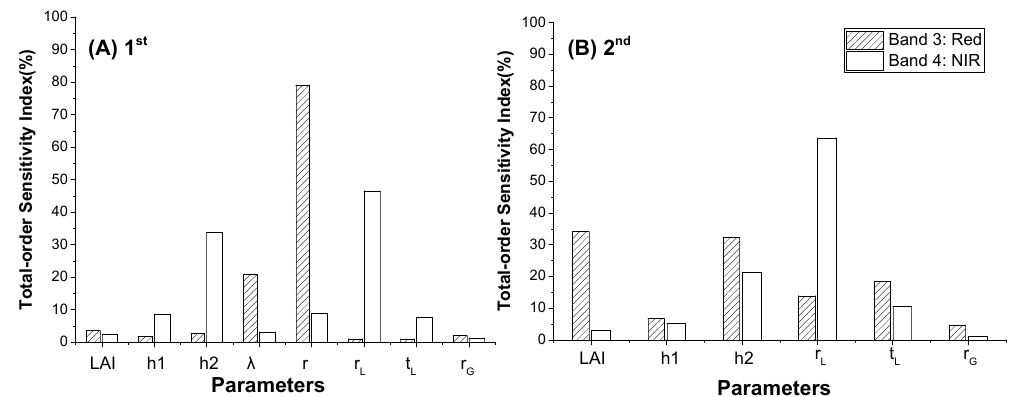
Figure 4. Results for the first ( A ) and second ( B ) global sensitivity analyses of the GORT model in the third (red) and fourth (NIR) Landsat bands for the following parameters: LAI (leaf area index), h 1 (lower boundary of canopy center height), h 2 (upper boundary of canopy center height), λ (tree stem density (trees/ha)), r (crown radius), r L (leaf reflectance), t L (leaf transmittance), and r G (background reflectance).